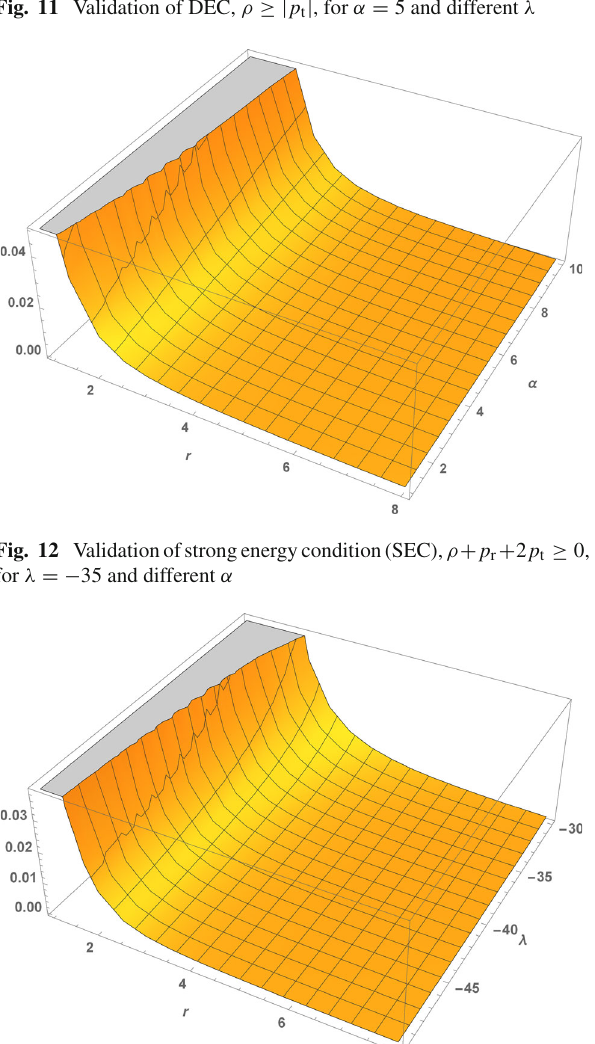
Fig. 11 Validation of DEC, ρ ≥ | p t | , for α = 5 and different λ